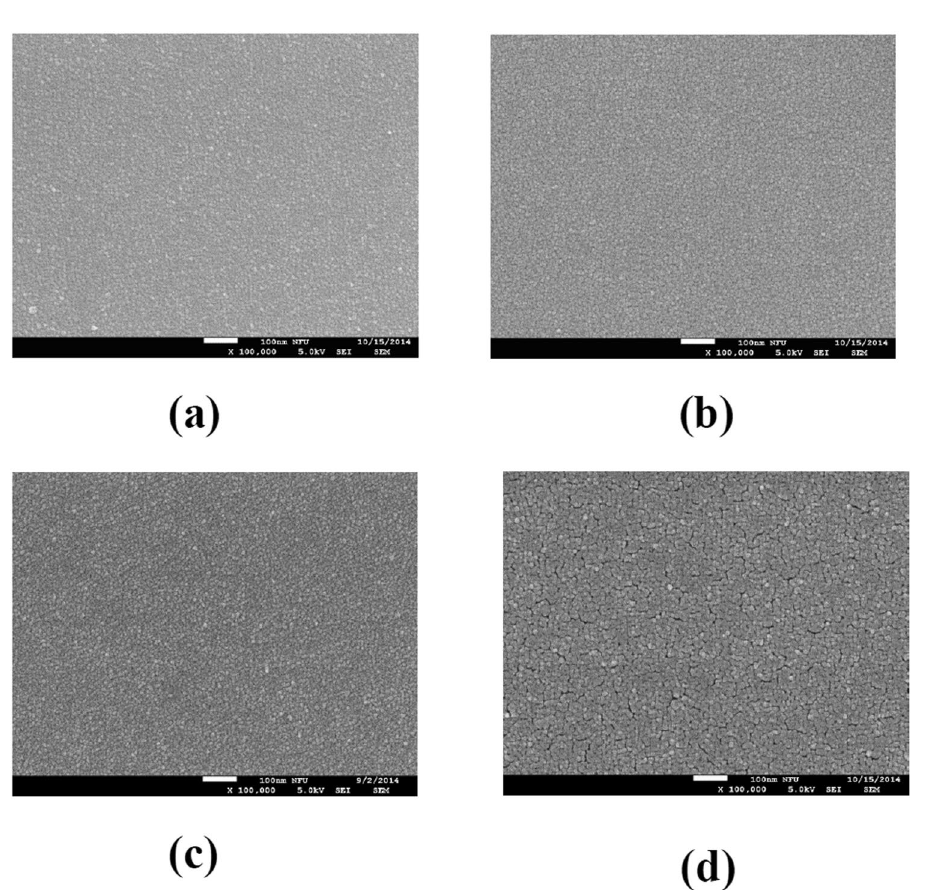
Figure 2. FESEM images of ( a ) the as-deposited CeO 2 sample ( b ) the Ce 2 Ti 2 O 7 sample ( c ) the as-deposited CeO 2 sample with NH3 plasma treatment for 3 min ( d ) the Ce 2 Ti 2 O 7 sample with NH 3 plasma treatment for 3